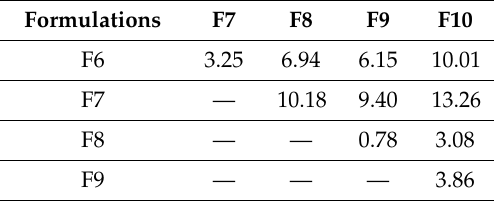
Table 4. The values of Tukey’s HSD